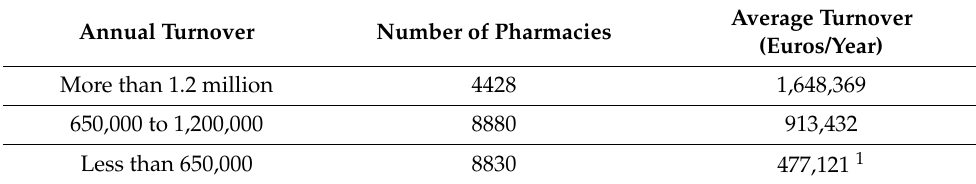
Table 2. Number of pharmacies by annual average billing values in 2019 in